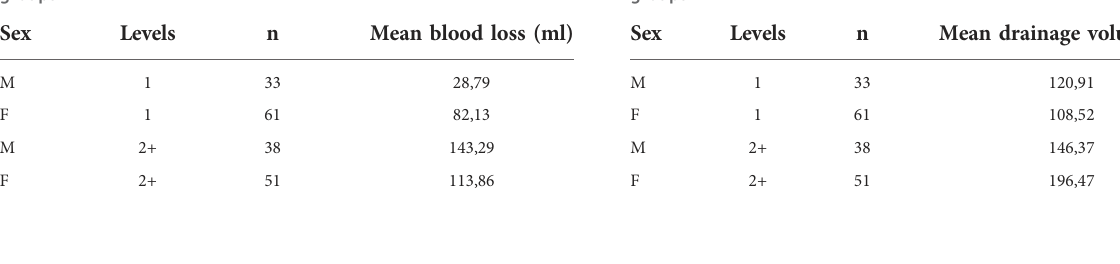
TABLE 2 Blood loss in patients in the “ one-level ” and “ two-plus ” level